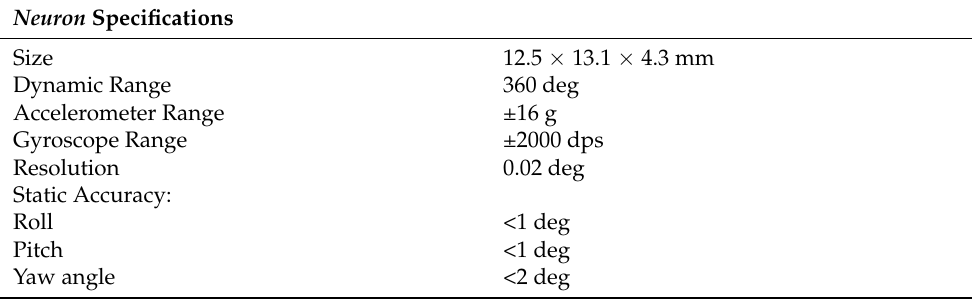
Table 2. Specifications of the Perception Neuron sensing